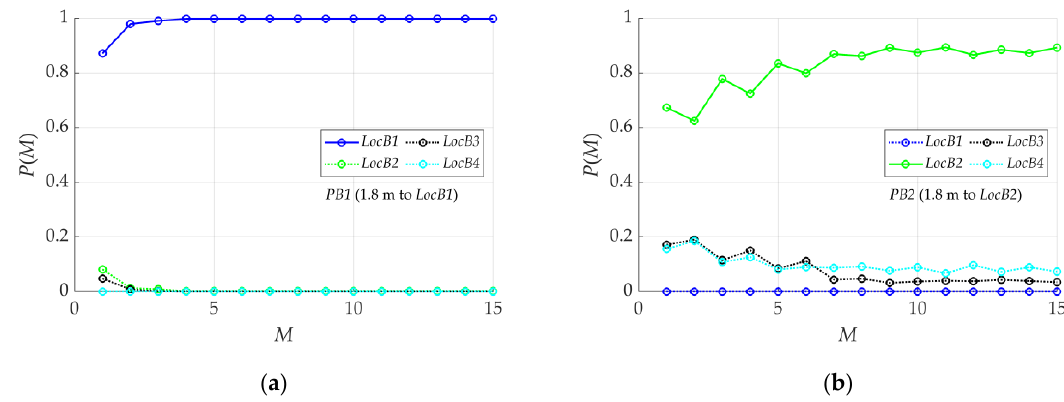
Figure 19. Probability of detecting each of the locator nodes depending on the width M of the moving window for an object located at a distance of 1.8 m from the receiver: ( a ) LocB1 (location PB1 ); ( b ) LocB2 (location PB2 ).